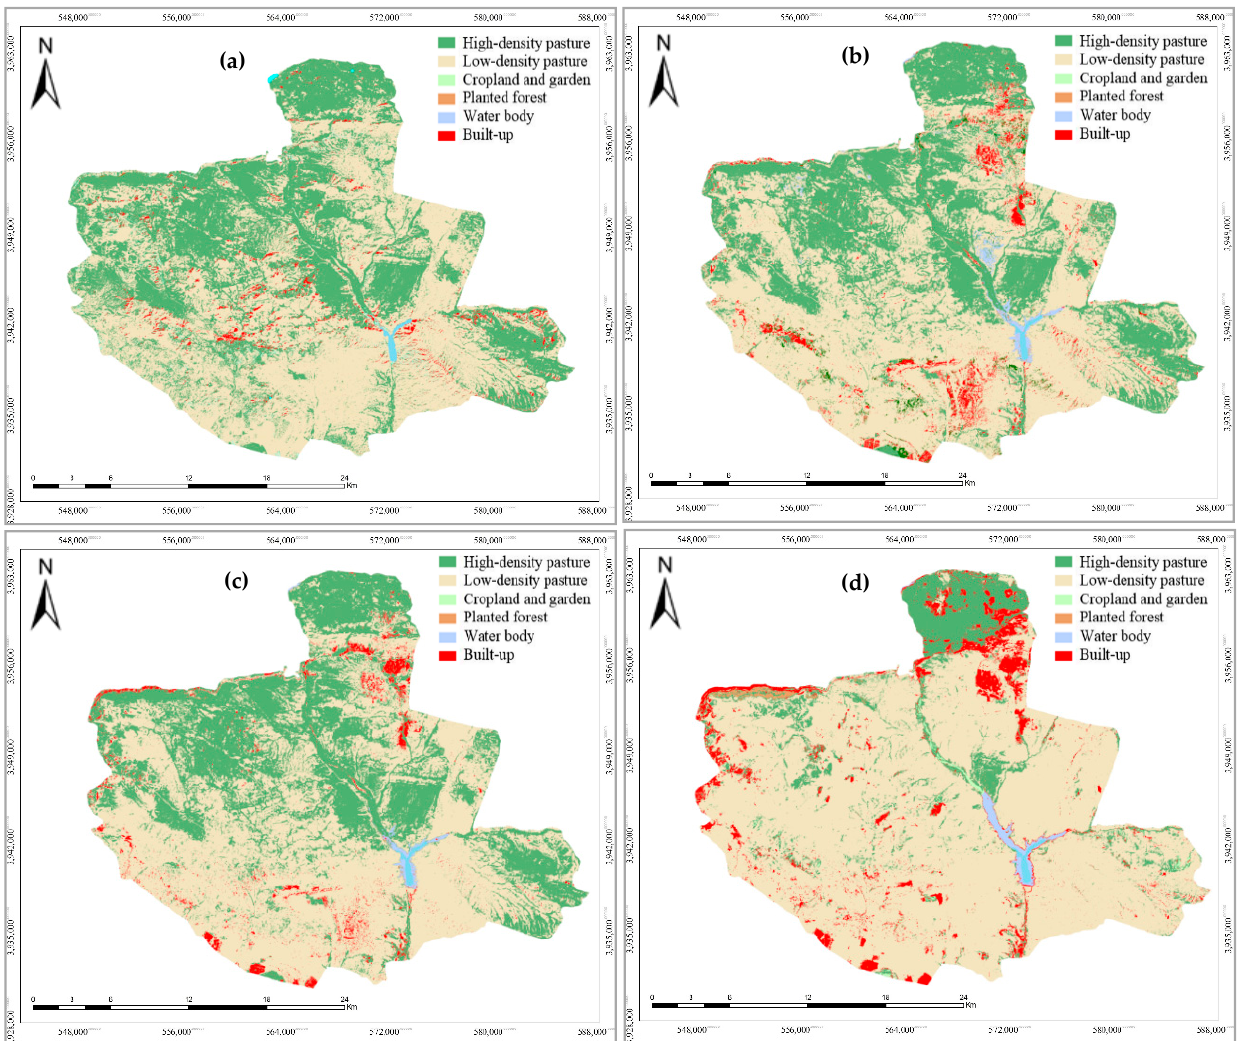
Figure 5. Temporal LULC maps in the Jajrud PA; ( a ) 1989, ( b ) 1999, ( c ) 2009, ( d ) 2019.